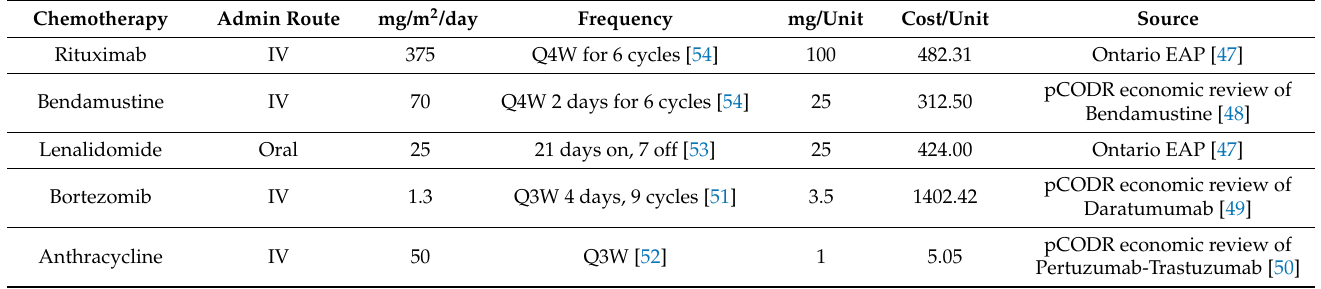
Table A4. Dosing of best supportive care therapies.